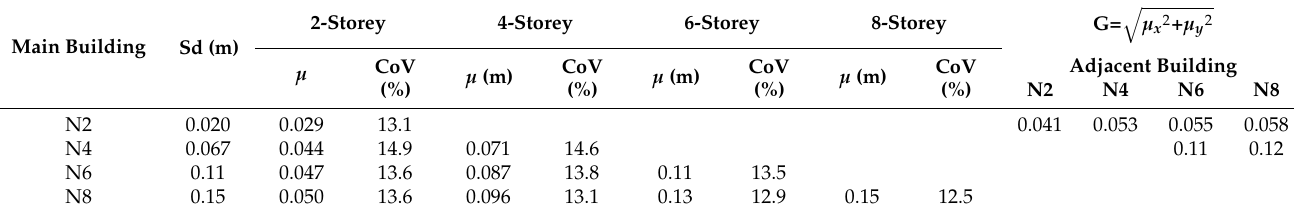
Table 1. Statistics of the lateral displacement of the structures at different levels obtained from dynamic analyses, spectral displacement of the structures, and reference values G of the separation distance for pairs of adjacent buildings.